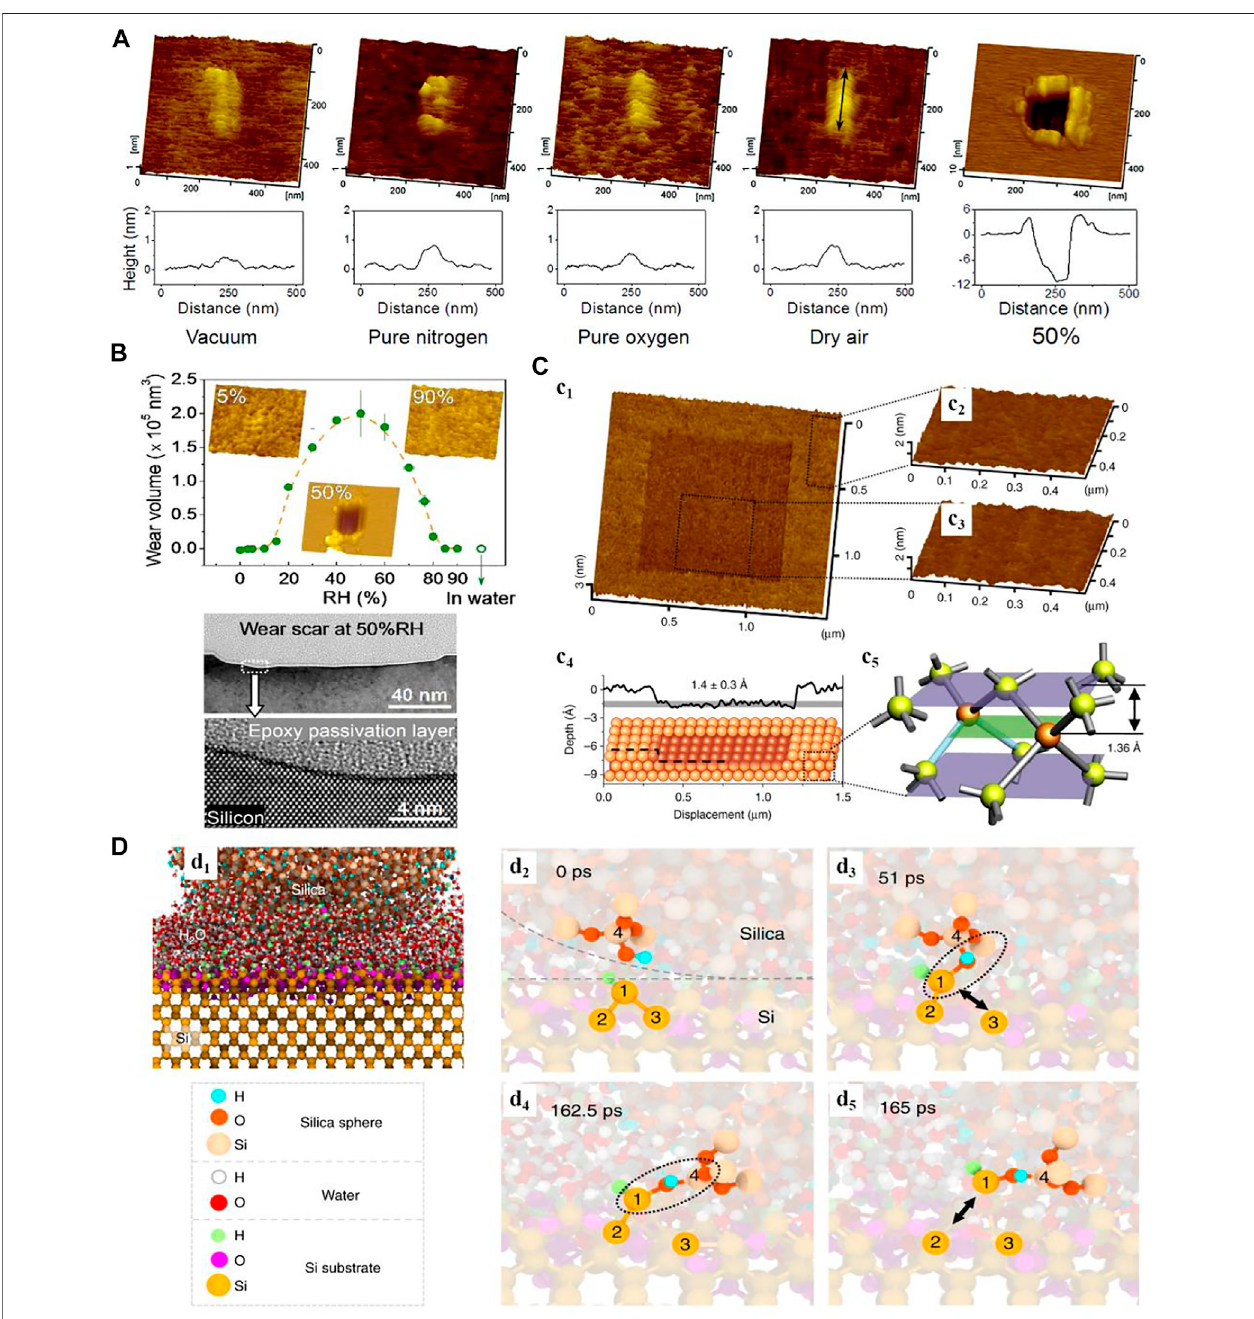
FIGURE 3 | (A) Topographies of the wear scars on the silicon surface after sliding against silica microspheres in different environments. Adapted from Bingjun Yu et al., 2012 (B) RH-dependent tribochemical wear of silicon (upper) and TEM observations on the cross section of a tribochemical wear scar on the silicon surface. AdaptedfromWangetal.,2015 (C) Singleatomiclayerremovalofoxide-freeSi(100)surface.AdaptedfromLeiChenetal.,2018 (D) ReaxFF-MDsimulationshowingthe processesoftheinterfacialbondformingandsubstratebondsbrokeninatypicaltribochemicalwearoftheSisurfaceagainstasilicananosphere.AdaptedfromLei Chen et al.,